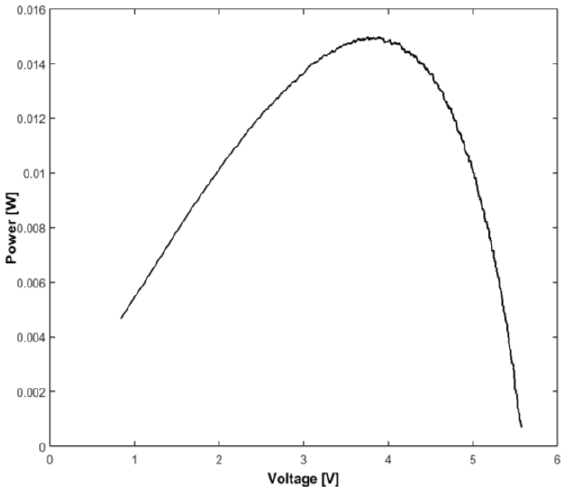
Figure 3 . P-V curve of photovoltaic Cell.